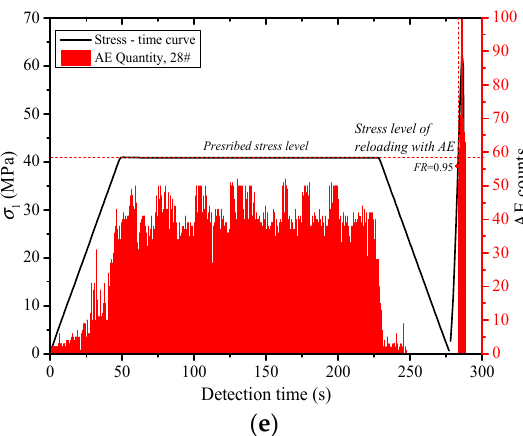
Figure 7. Stress–time-AE curves in uniaxial cyclic loading and unloading test of red sandstone under different loading rates ( σ A = 0.7 σ c ). ( a ) l r = 0.001 mm/s; ( b ) l r = 0.005 mm/s; ( c ) l r = 0.01 mm/s; ( d ) l r = 0.05 mm/s; ( e ) l r = 0.1 mm/s.